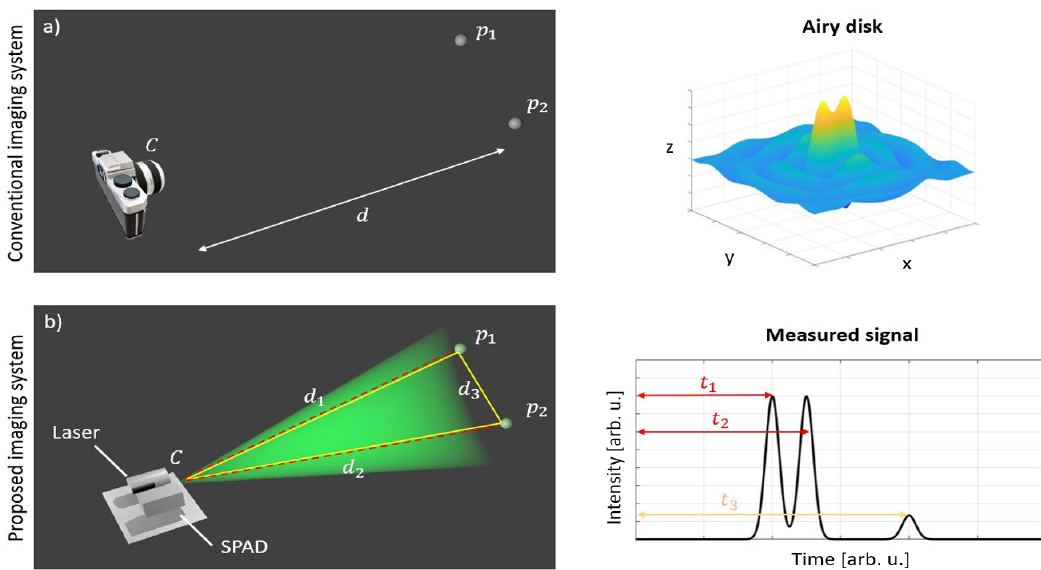
Figure 1. Comparison between conventional and Time Encoded Remote Apertures (TERA) imaging system. ( a ) Conventional imaging system. To infer the position of an object within the focal plane, an imaging system needs to determine the length difference between two rays. The figure shows a fundamental relation between distance, resolution, and aperture. The resolution of the system is determined by the Rayleigh’s criterion. ( b ) TERA imaging system. A pulsed laser illuminates the scene, and the SPAD detects the light reflected back from the scene. The collected time response contains information about the distance between the two targets. The resolution of the system is determined by the time resolution of the